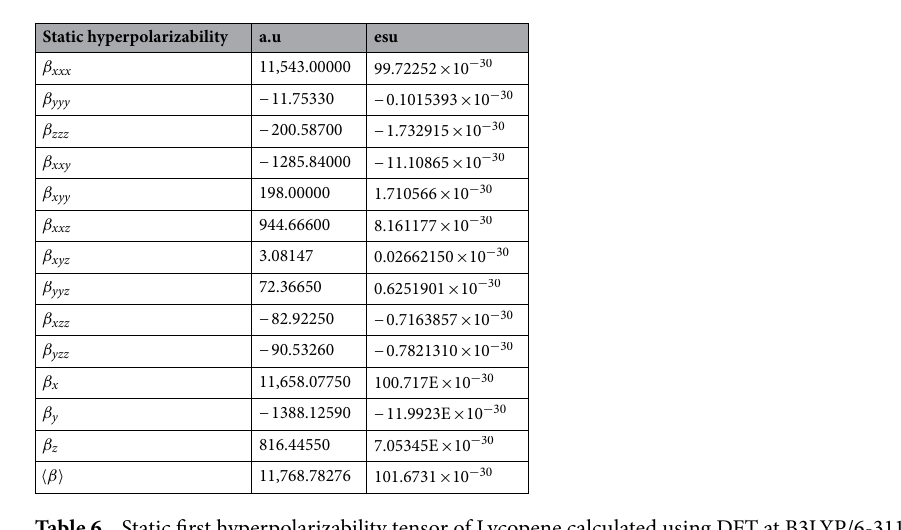
Table 6. Static first hyperpolarizability tensor of Lycopene calculated using DFT at B3LYP/6-311 level of theory (in a.u. unit) and converted values to esu.